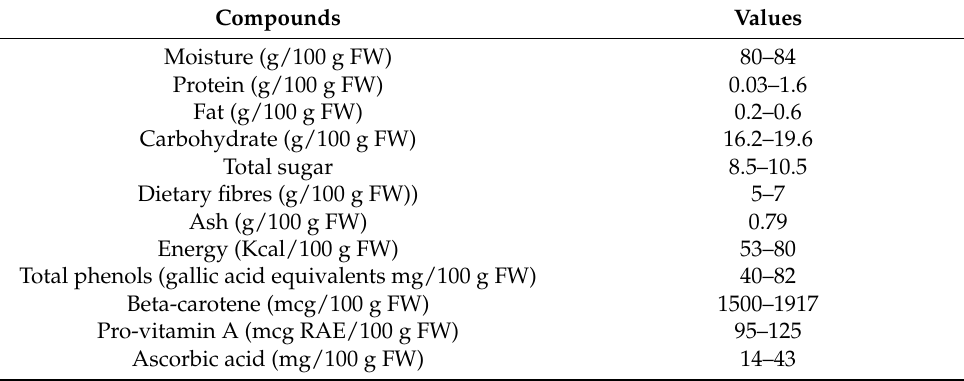
Table 1. Main nutrients and phytochemicals composition of golden berry